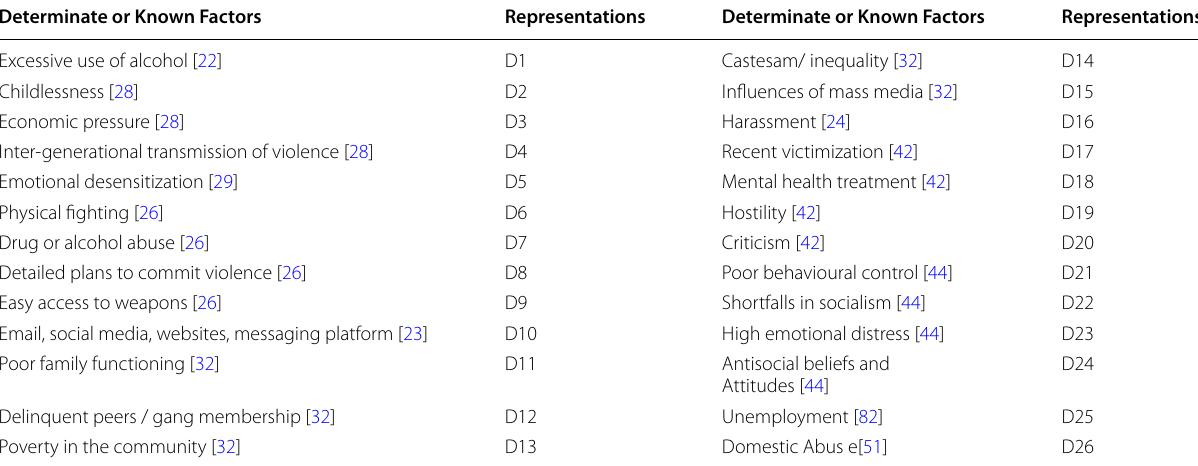
Table 3 Determinate or Known Factors